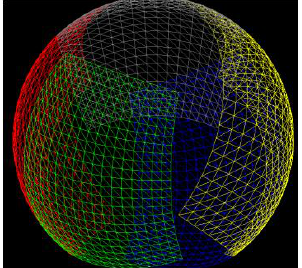
Figure 3. A virtual sphere representing one virtual spherical